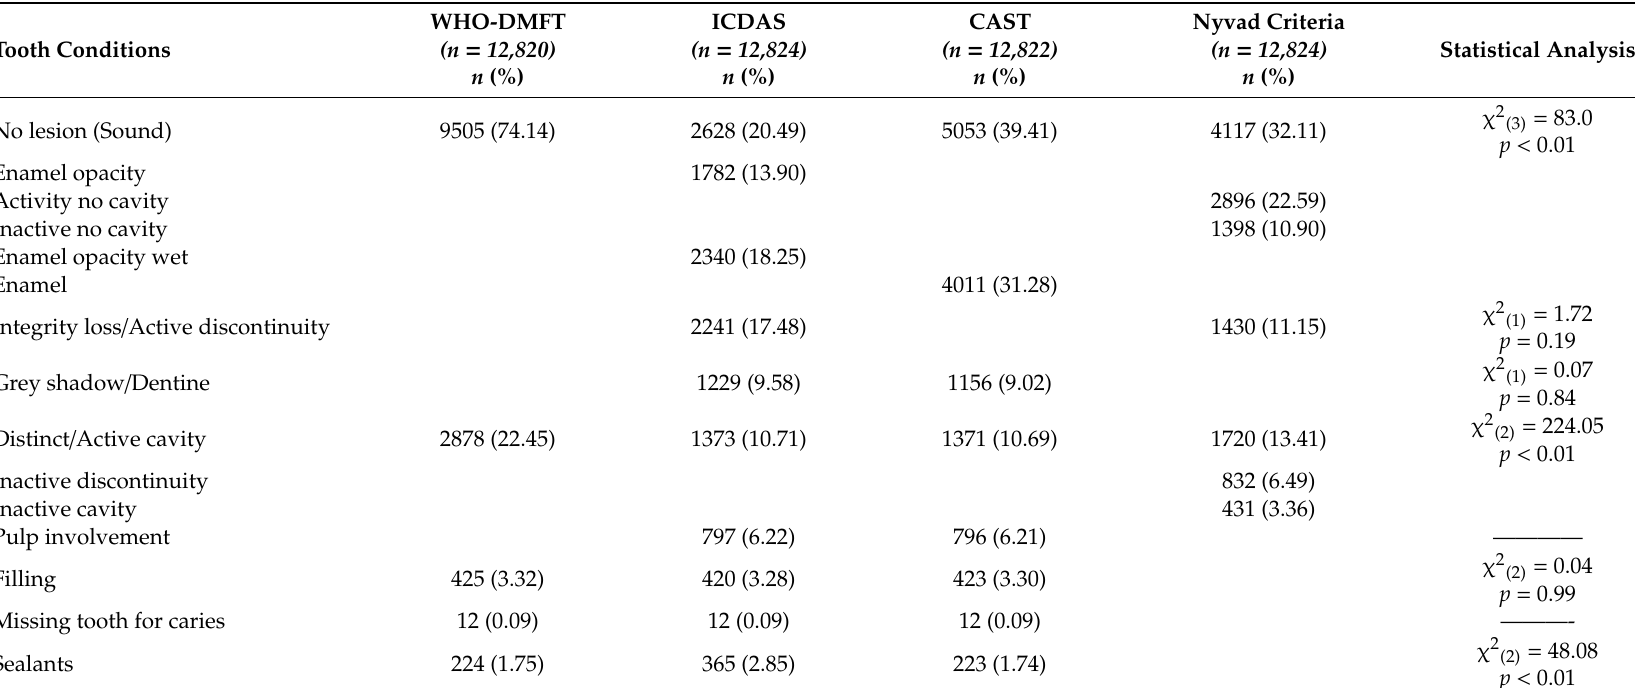
Table 6. Accordance among the WHO-DMFT, ICDAS, CAST, and Nyvad Criteria methods related to tooth condition. Percentage of Accordance error refers to the